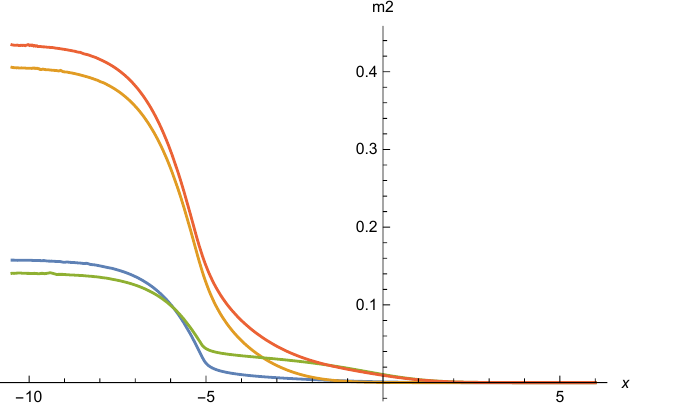
Figure 18. Mass term u (cid:48) ( ˜ ρ ) as function of x = ln ˜ ρ . Values of parameters and color coding are the same as in Figure 17. The two upper curves on the left (red and orange) correspond to ξ ∞ = 1.0, the two lower ones (blue and green) to ξ ∞ =